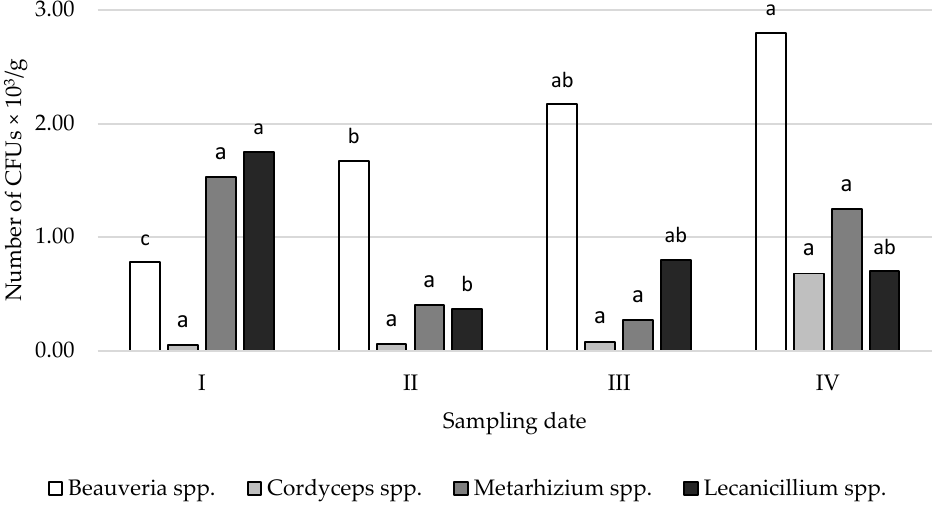
Figure 4. Average density of CFUs of entomopathogenic fungi in forest soils collected in Chodów, depending on the date of sampling for research. abc Statistically significant differences between the concentration of CFUs of entomopathogenic fungi in the studied soils and the time of the study.